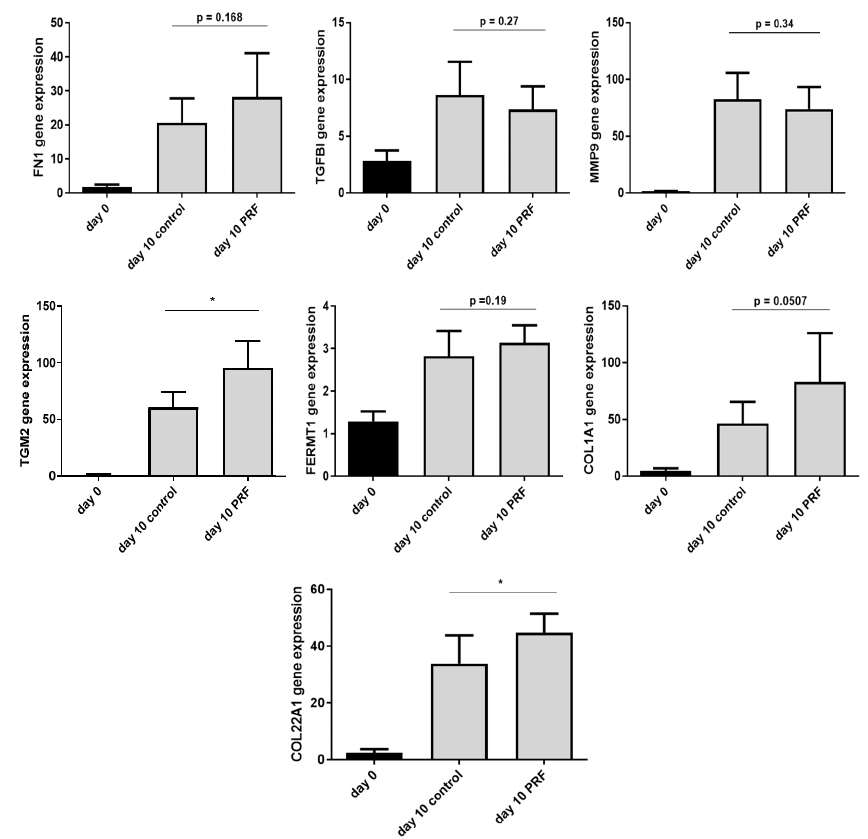
Figure 6. In vivo influence of Platelet-Rich Fibrin (PRF) on experimentally generated wounds. Experimentally generated bilateral gluteal wounds (biopsy punch, Ø 4 mm) of 10 test persons were treated by day 0 and day 5 with Vivostat PRF ® or NaCl 0.9% as control. After 10 days, wound areas were resected (biopsy punch, Ø 6 mm) and gene expression of the indicated factors was determined by real-time PCR (* p < 0.05, Student’s t